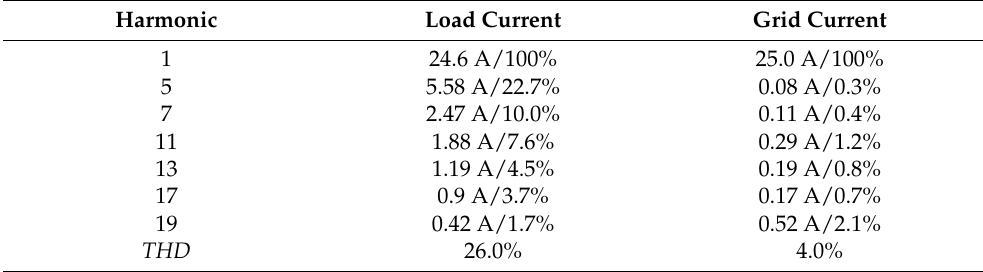
Figure 19. Operation of HAPF with the load Ld2: ( a ) the grid current, the load current and the power converter voltage waveforms; ( b ) harmonic spectrum of the grid and the load currents. Table 4. Comparison of the load currents and the grid currents for HAPF with the load Ld2.